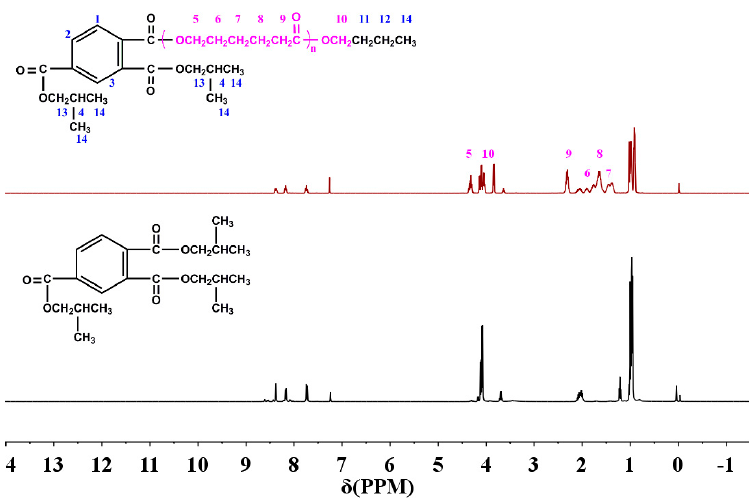
Figure 9. 1 H-NMR spectra of TMT.